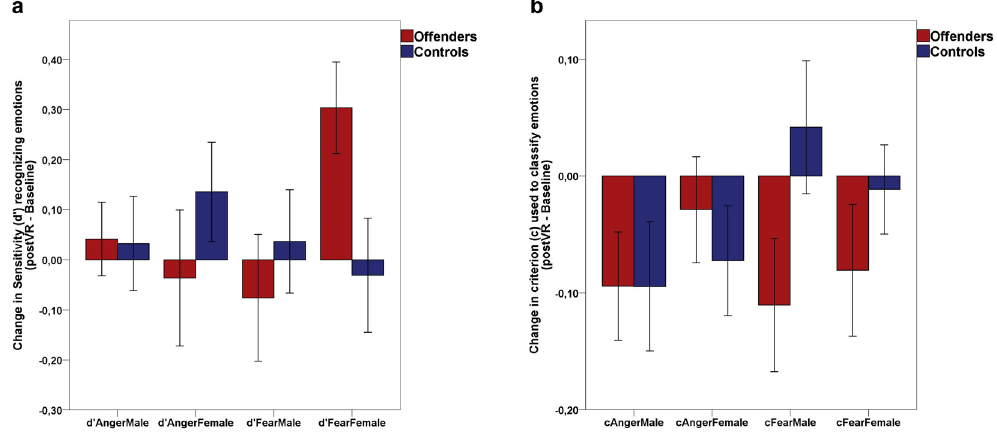
Figure 3. Change in sensitivity d ′ (facility) to recognize facial emotions and in bias (c) towards classifying faces as depicting a particular facial emotion after the immersive virtual reality experience in domestic violence male offenders and non-offender male controls. ( a ) Means and standards errors of the differences (post-VR minus baseline) in sensitivity index d-prime (d ′ ) scores obtained in the Face Body Compound Test, a higher value indicating a higher increase. ( b ) Means and standard errors of the differences in bias (c) in the Face-Body Compound test, where a c value of 0 indicates no change; a positive value of c indicates an increase in